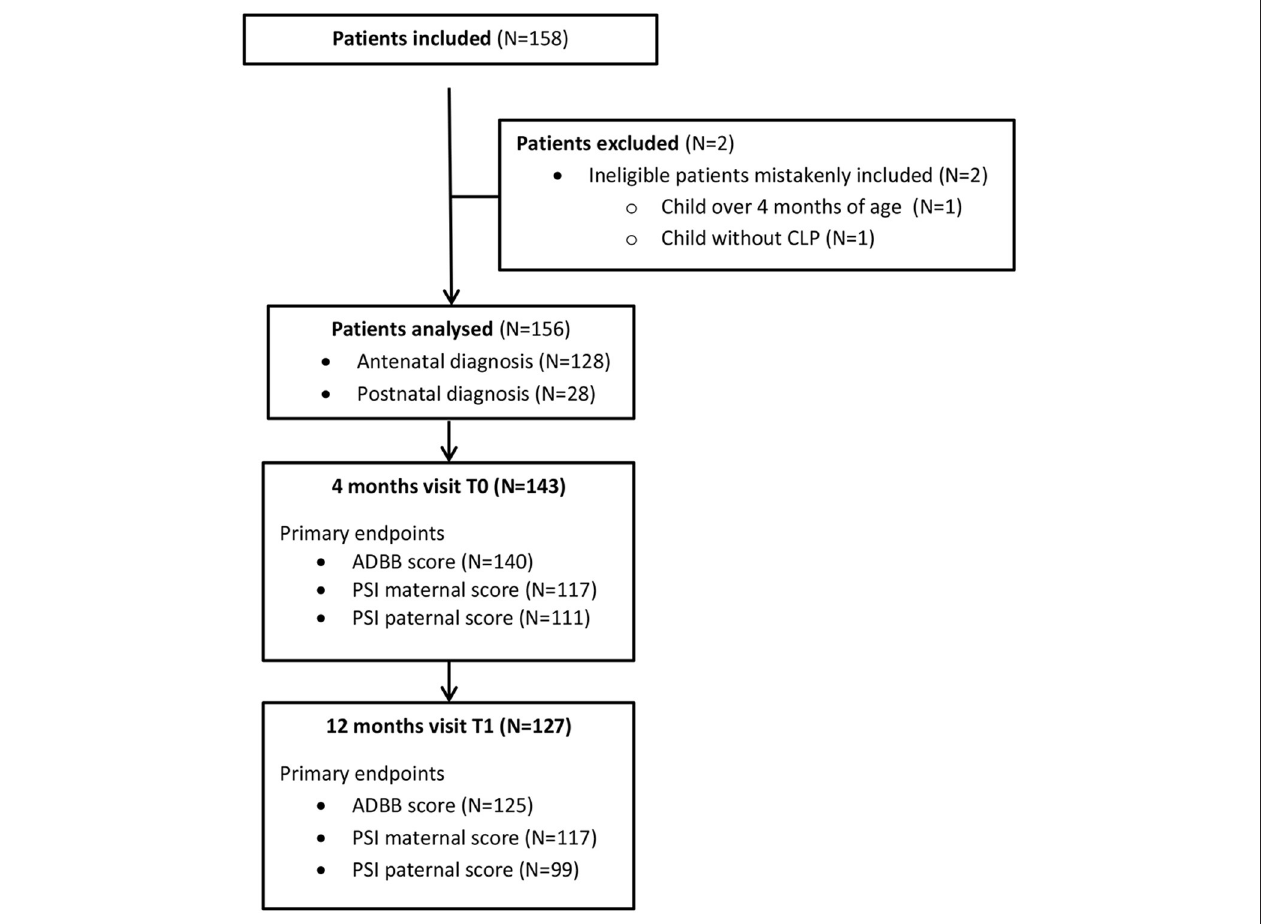
FIGURE 1 | Flowchart of the